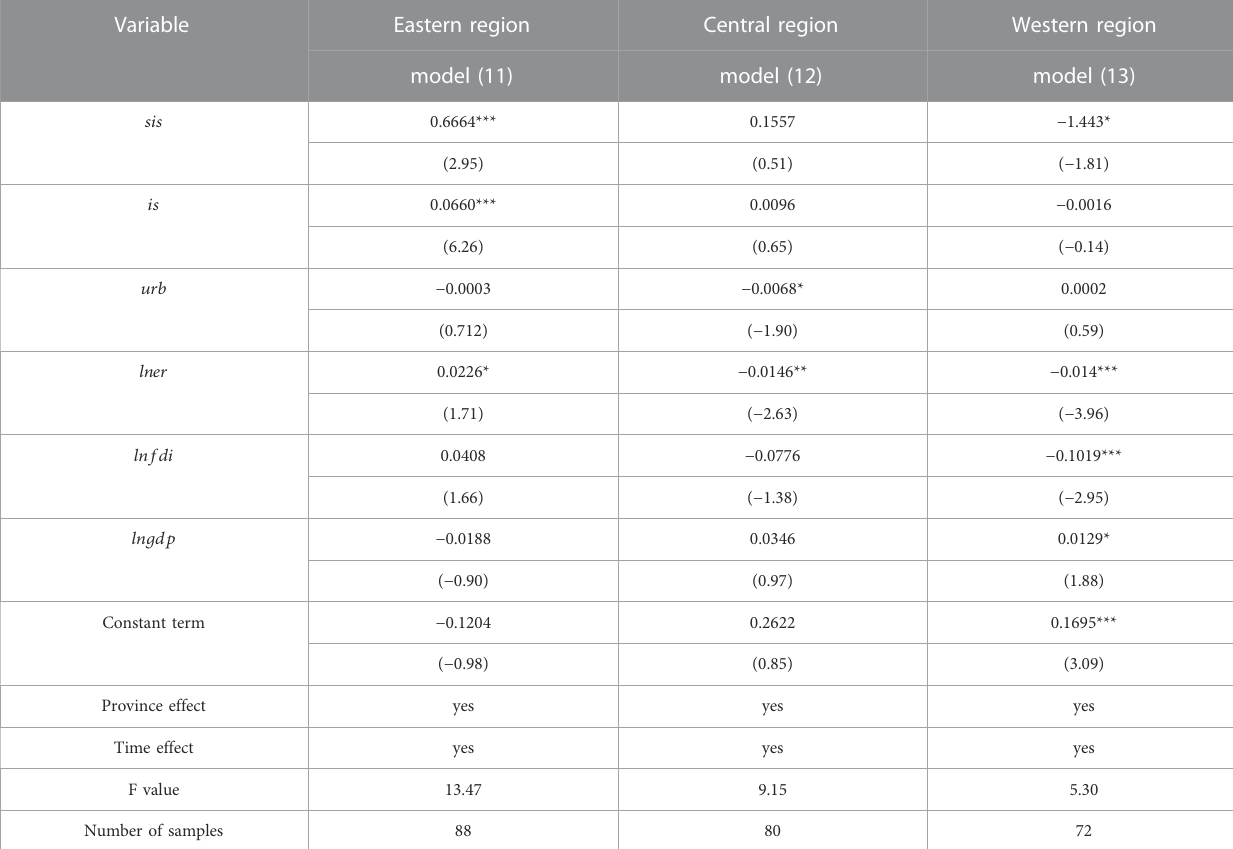
TABLE 6 Regression results of eastern, central and western